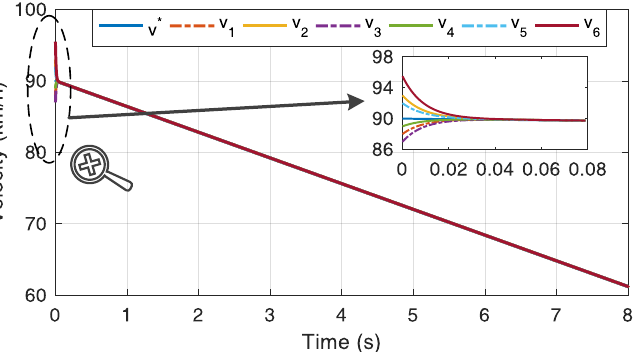
Figure 3. Velocity curve of each carriage with the proposed consensus braking controller in case 1. Figure 4 provides the relative displacement variations between any adjacent